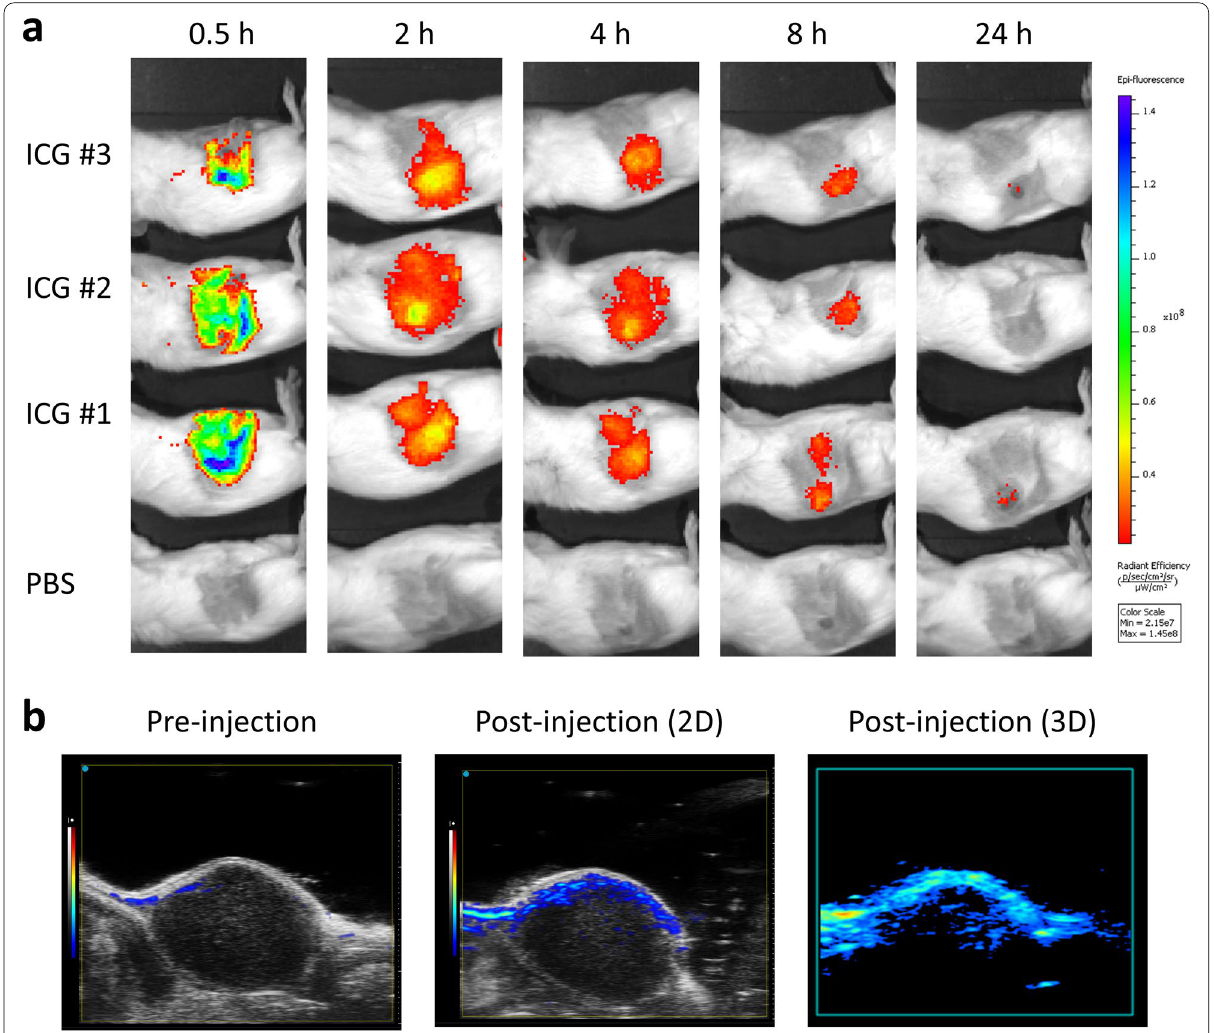
Fig. 5 Fluorescence imaging and photoacoustic imaging of ICG in vivo . a Representative IVIS images of tumor-bearing mice 0.5 h, 2 h, 4 h, 8 h, and 24 h after administration of ICG ( n 3 per group). b Representative PA images of the tumor region were acquired pre-injection and 15 min =